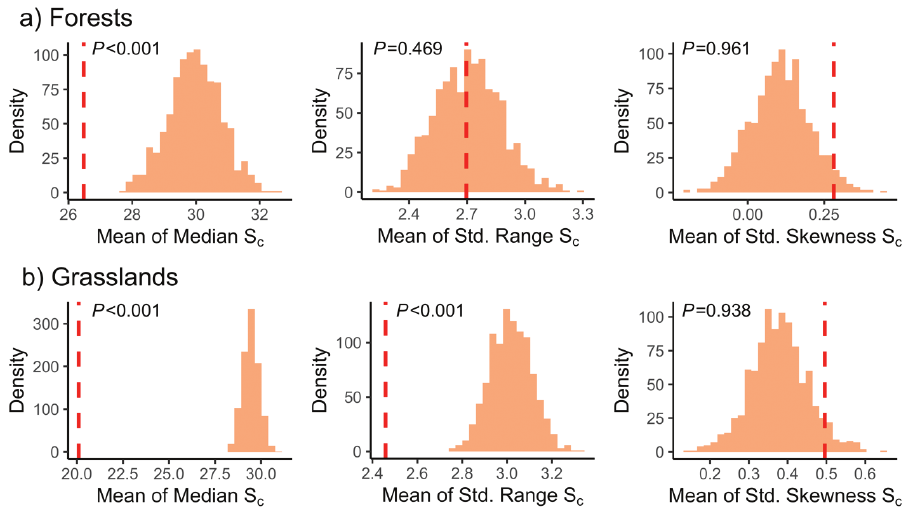
Figure 3. Comparison of mean observed values of the median (1 st column), range (2 nd column) and skewness (3 rd column) of S of naturalized neophytes with the distribution of mean random values of the c same parameters obtained from the null model. Results are for species in ( a ) forests and ( b ) grasslands. The dashed red line represents the mean observed value of each parameter across all species. The bars show the distribution of random values of each parameter. The range and skewness of S were standardised (Std.) c as described in the Methods section. P -values indicate the proportion of the randomised parameters that are lower than the observed